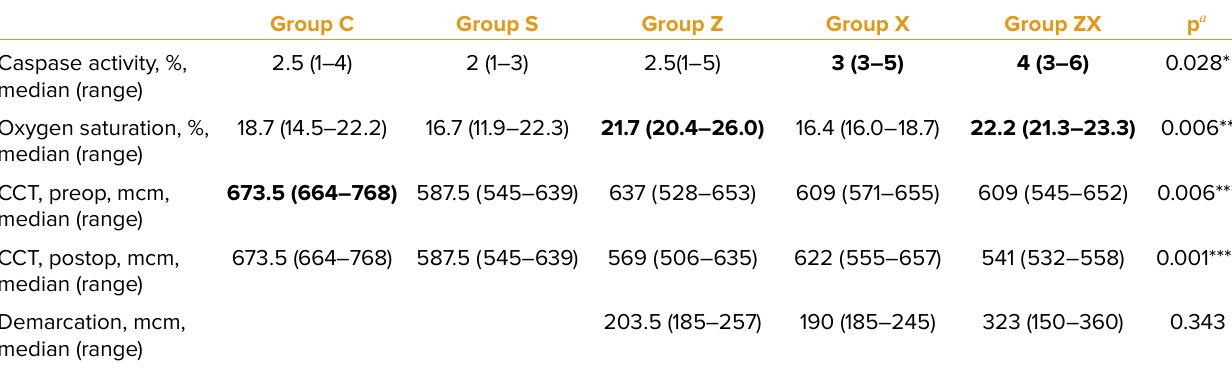
Table 1. Between and within groups comparison of the examined parameters. Group C Group S Group Z Group X